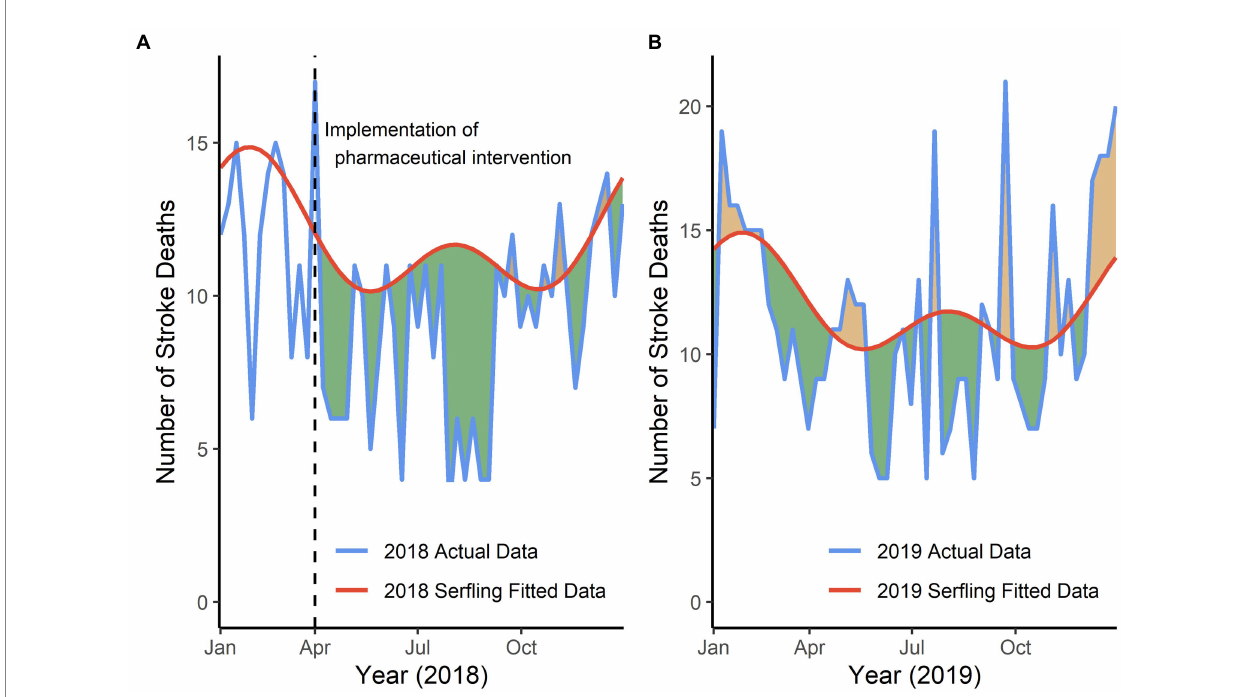
FIGURE 3 Reduction in number of weekly stroke deaths in Deqing, 2018–2019, respectively. (A) Green shadows were presented as the reduction in actual stroke deaths compared with predicted numbers since April 2018, in the presence of only pharmaceutical intervention effect, in which there was a significant reduction of 19% ( t = − 4.26, p < 0.001). (B) Green shadows were presented as the reduction in actual stroke deaths compared with predicted numbers in year 2019, in the presence of only pharmaceutical intervention effect, in which there was a reduction of 7% ( t = − 1.47, p =